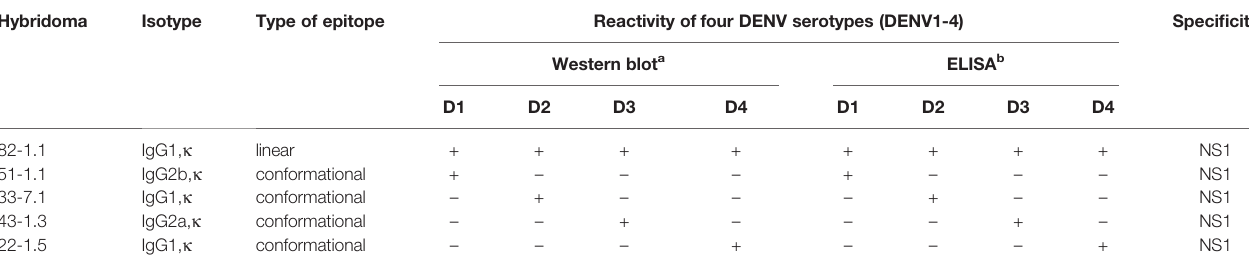
TABLE 1 | Characterization of reactions between mAbs and DENV NS1